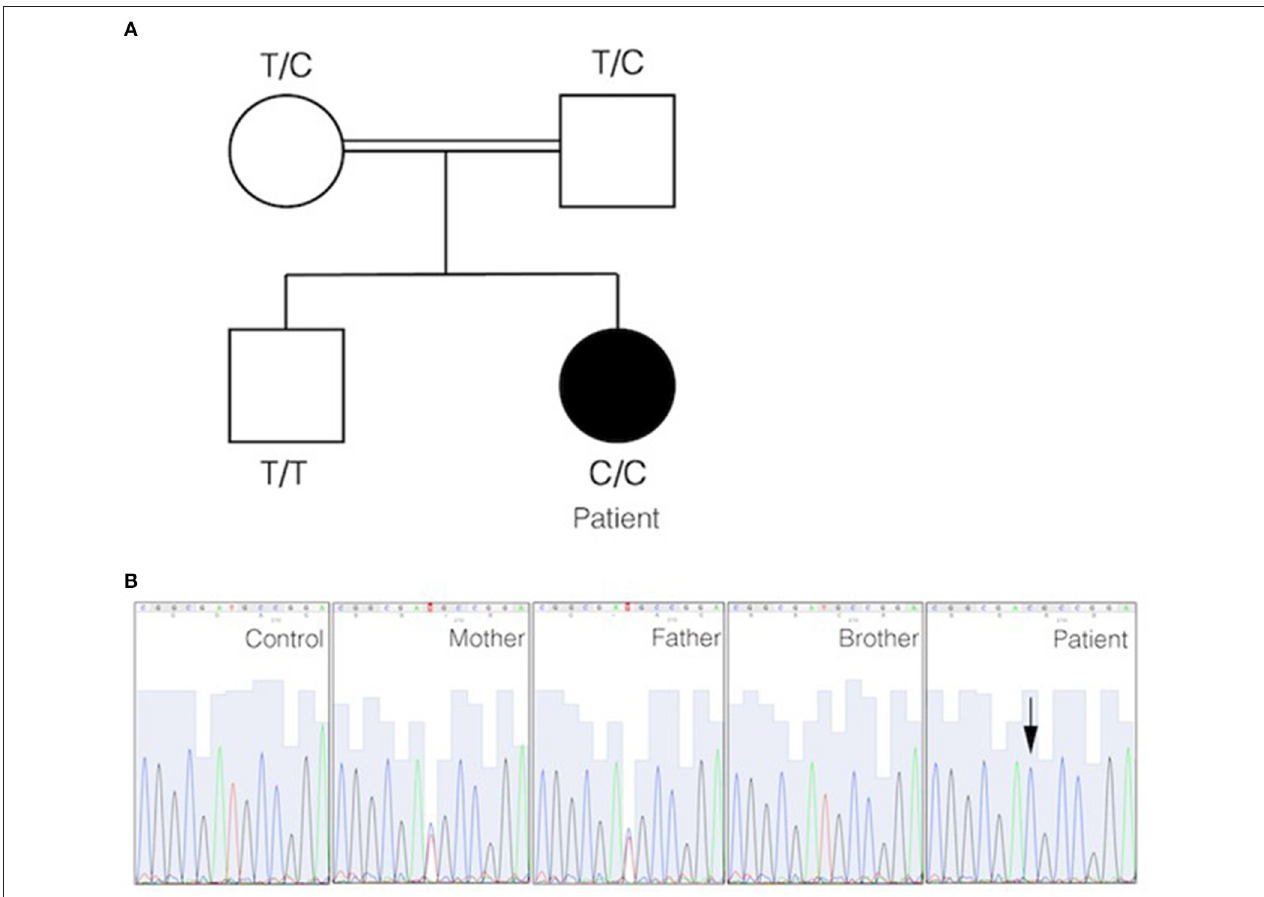
FIGURE 2 | Identification of start filled loss mutation in CD70. (A) Pedigree of the family in which a homozygous start loss mutation in CD70 was identified. The genotype of each individual is indicated. The black circle represents the affected individual. (B) DNA electropherograms show the region containing the mutation in CD70 in the family. The homozygous missense mutation is indicated by an